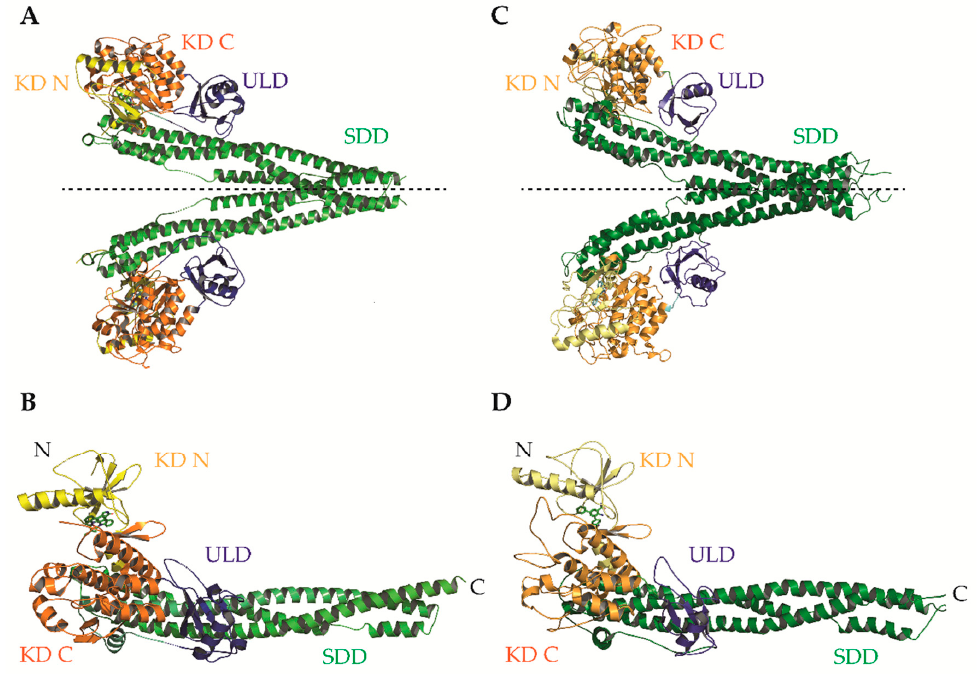
Figure 2. X-ray crystal structures of human IKK β and IKK α . ( A ) Ribbon diagram of the crystallographic structure of the human IKK β dimer. The N-terminal lobe of the kinase domain (KD) (KD N; residues 1–109), C-terminal lobe of the KD (C; residues 110–307), ubiquitin-like domain (ULD; residues 308–404) and scaffold/dimerization domain (SDD; residues 410-664) are coloured in yellow, orange, blue and green, respectively. The NEMO-binding domain (NBD) at the extreme N-terminus was not resolved in the original structure. Figure adapted from [5]. PDB ID: 4KIK. ( B ) Ribbon diagram of the human IKK β protomer showing the tri-modular architecture of KD, ULD, and the elongated, α -helical SDD. Figure adapted from [5]. PDB ID: 4KIK. ( C ) Ribbon diagram of a model of a human IKK α dimer derived from X-ray crystallographic data. Figure adapted from [7]. PDB ID: 5EBZ. ( D ) Ribbon diagram of the human IKK α protomer showing the same tri-modular architecture of domains as IKK β . The NBD at the extreme N-terminus was also not resolved in the original structure. Figure adapted from [7]. PDB ID: 5EBZ. The pseudo two-fold axis of the IKK β and IKK α dimers are indicated by a dashed line.